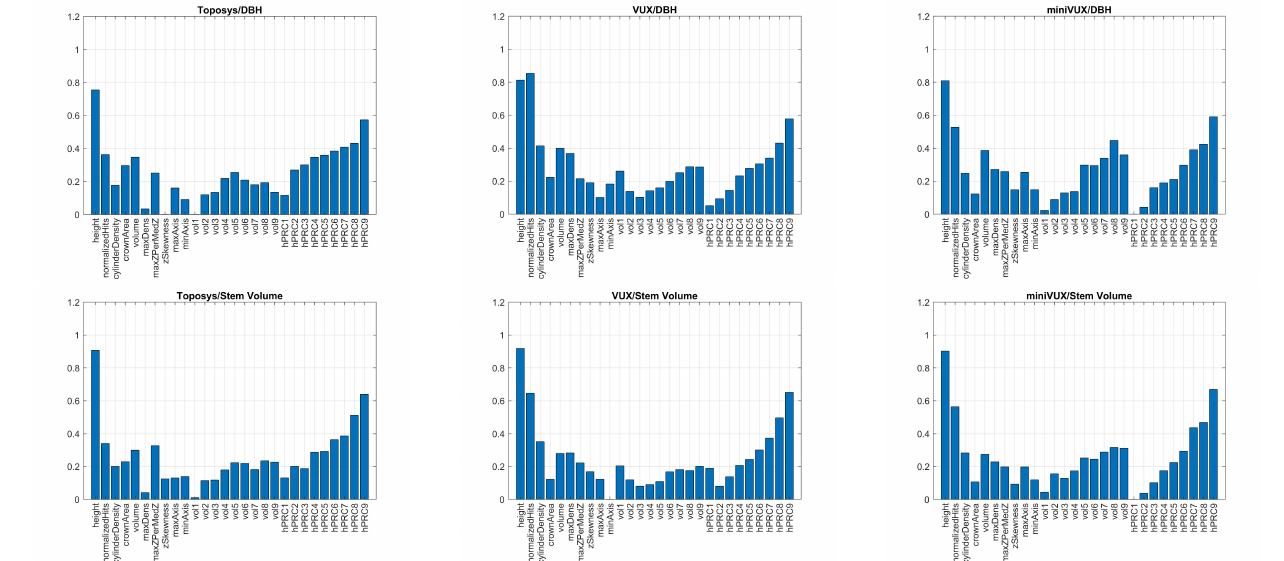
Figure 5. Indirect feature importance. Here the variables are the features in Table 4, and the predicted values are the